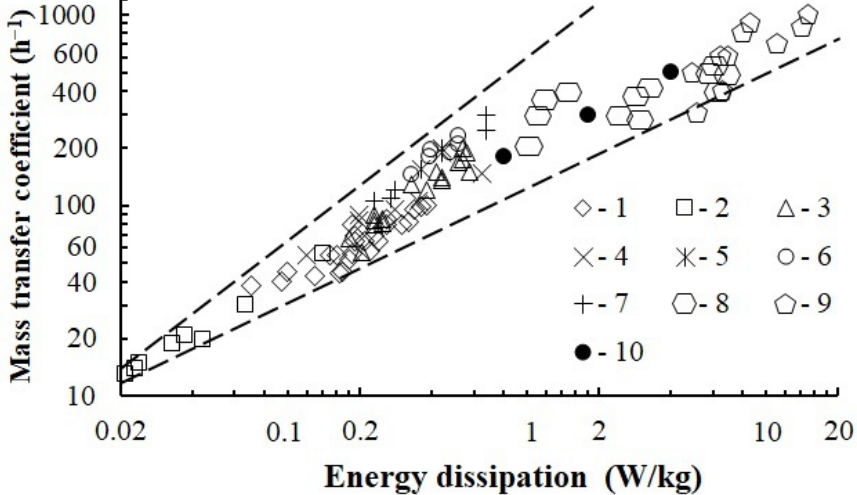
Figure 18. Dependence of the mass transfer coefficient on energy dissipation. Experimental points (1–7) bubbling without a stirrer [48]; 8—stirrer with bubbler (Figure 1a), [49] at D = 0.375 (m), H L / D = 1, d s = 0.110 (m), u g = 0.018–0.04 (m/s); 9—the method under study (Figure 1e) at H L / D = 1.2, D = 0.280 (m); 10—data [7].